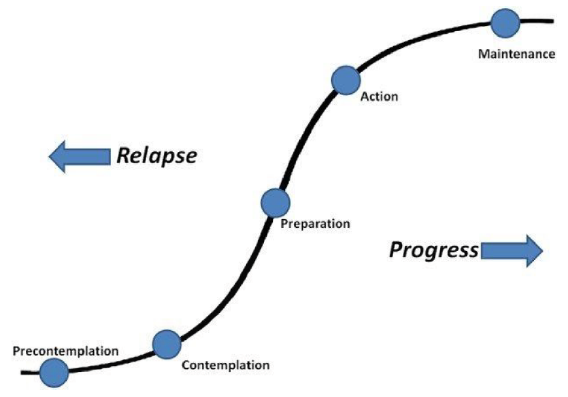
Figure 4. The stages of change according to the transtheoretical model to evaluate enhancement or relapse of behaviour